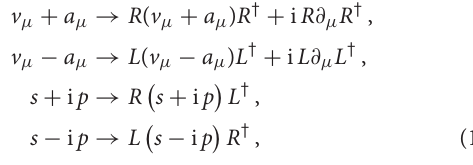
0 − ), baryon octet ( J P =